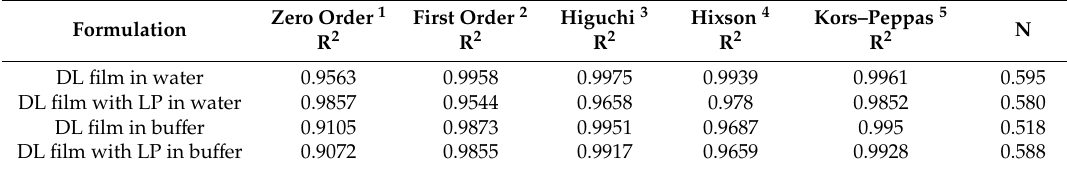
Table 7. In vitro release kinetic values.